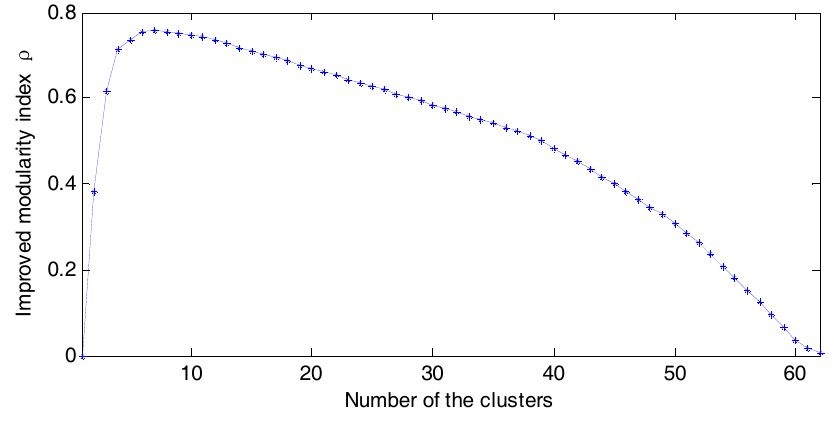
Figure 8. Improved modularity index ρ im versus the number of clusters.